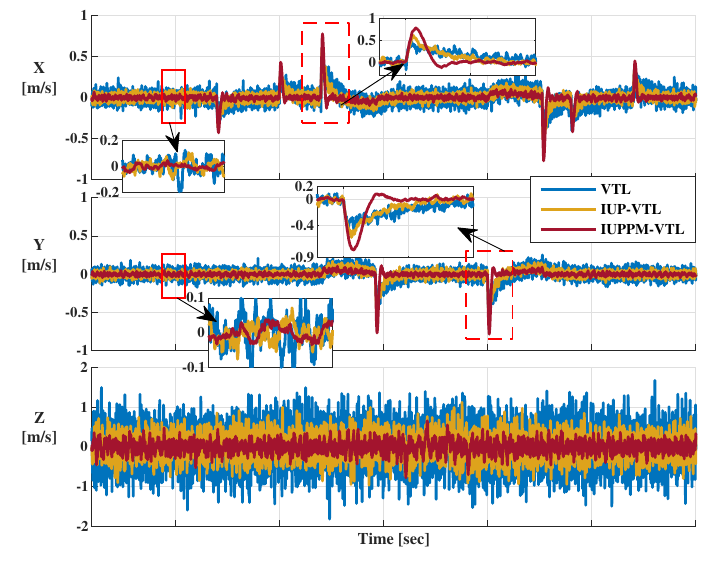
Figure 13. Velocity errors of three VTL structures in XYZ